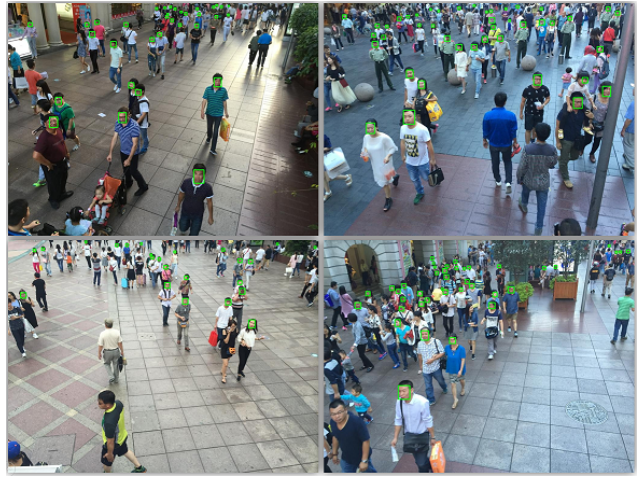
Figure 11. Examples of detected faces by